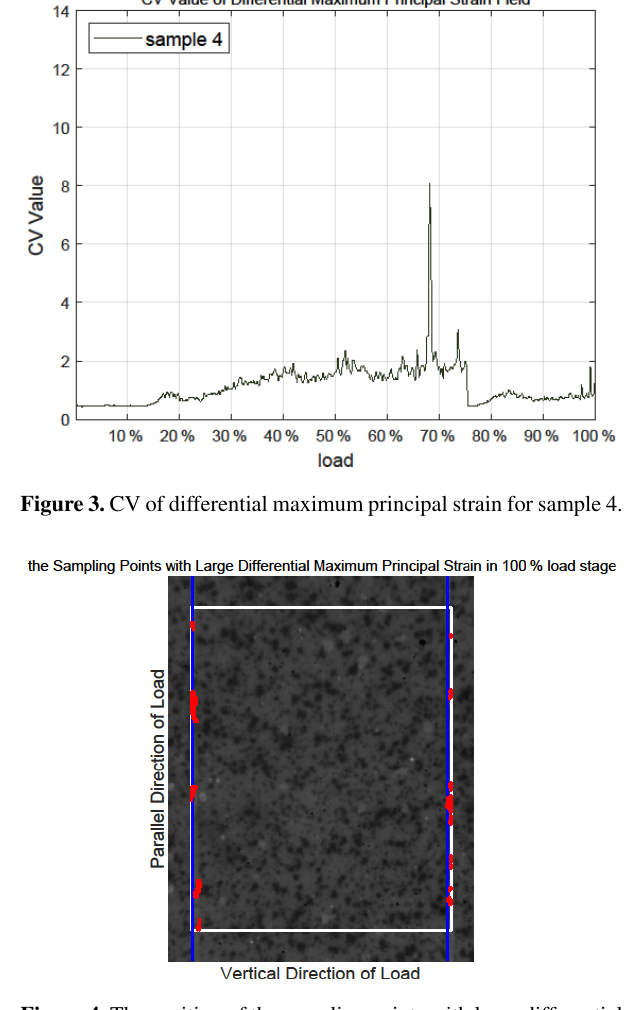
Figure 4. The position of the sampling points with large differential maximum principal strain for sample 4. The blue lines indicate the prefabricated cracks. Each figure shows the observational area of sample 4 in the experiments. The area enclosed by the white rect- angle is the calculation domain, and its size is constant in different loading stages. The red points represent the sampling points with large differential maximum principal strain that satisfy the judg- ment condition at the 100% load